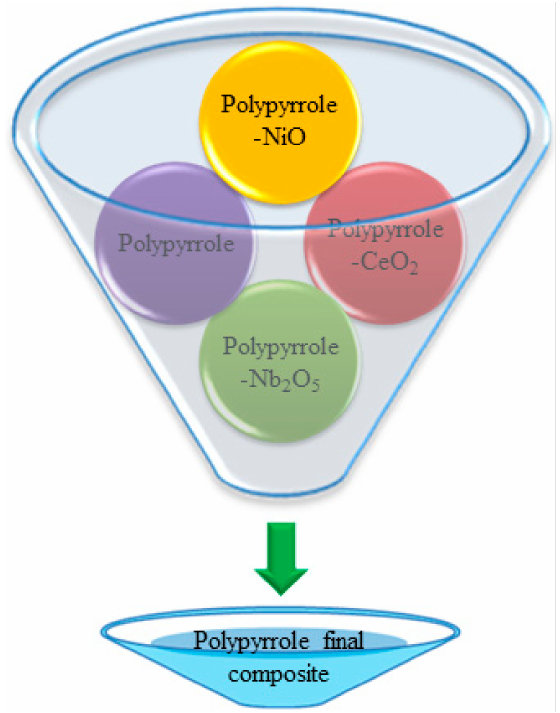
Figure 2. Mixing process of polypyrrole, polypyrrole-NiO, polypyrrole-CeO 2 , and polypyrrole- Nb 2 O 5 composite